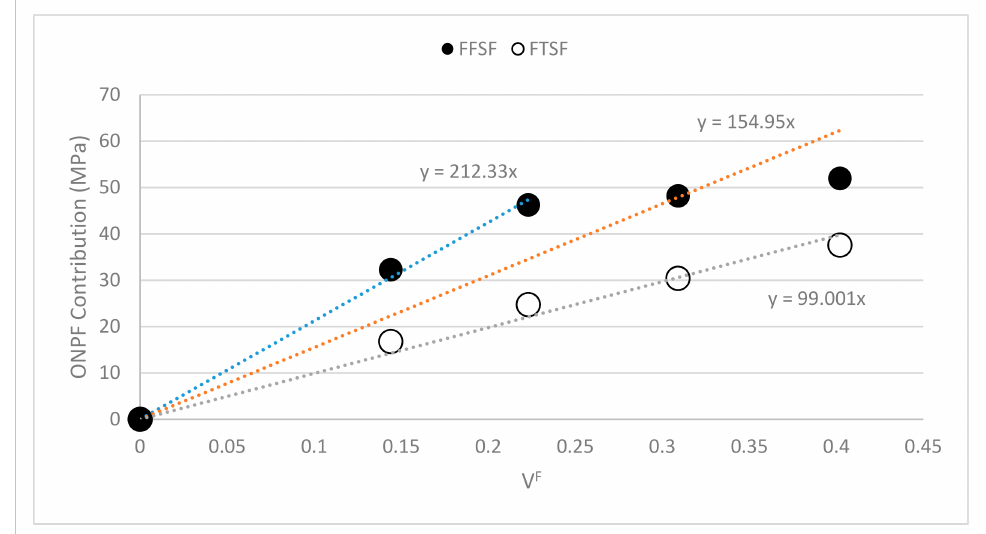
Figure 7. Fiber flexural strength factor and fiber tensile strength factor for the ONPF reinforced PP